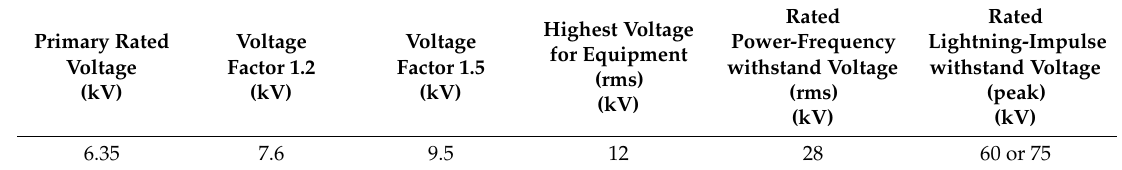
Table 1. Voltage withstand requirements for electronic voltage transformers with primary terminals having the highest voltage for equipment below 300 kV